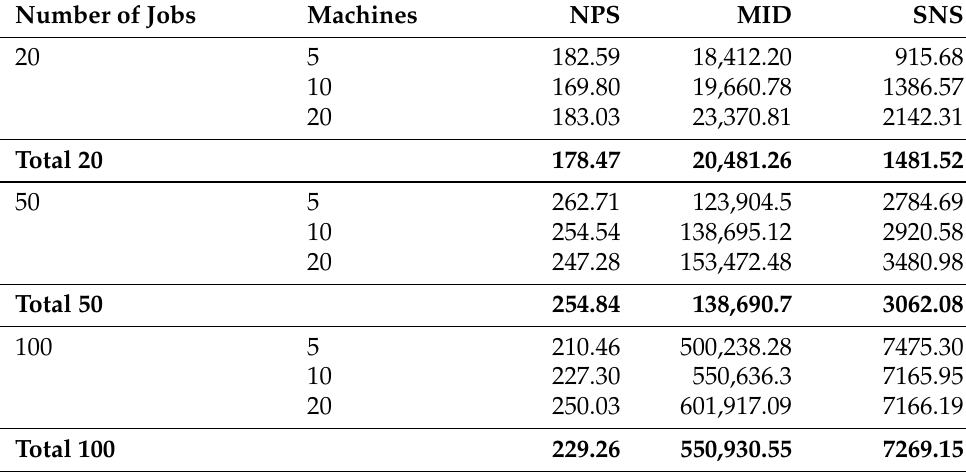
Table 11. Performance results of the proposed approach.